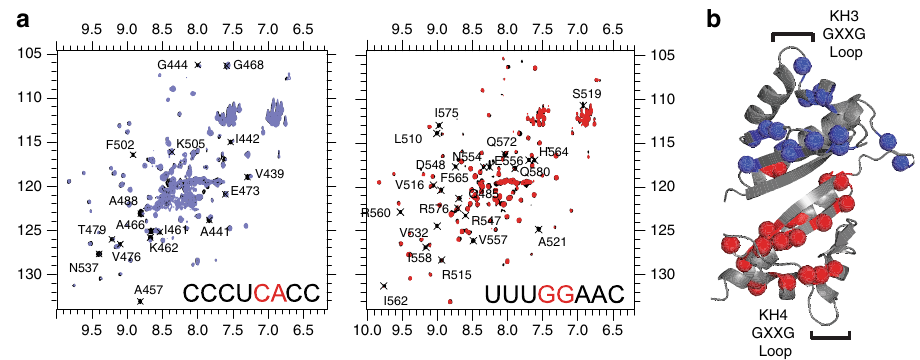
Fig. 3 IMP2 recognizes speci fi c RNAs through interactions between the GXXG motifs and the variable loops. a 1 H 15 N HSQC spectra of IMP2KH34 showing residues perturbed (black text) during separate titrations of the CA (left, blue) and GG (right, red) element containing RNAs. Sequence of the RNA used is depicted on bottom right of each spectrum. Enlarged spectra of the titrations are shown in Supplementary Fig. 3e. b Location of amide resonances altered upon binding to the CA element containing RNA (blue) and GG element containing RNA (red)